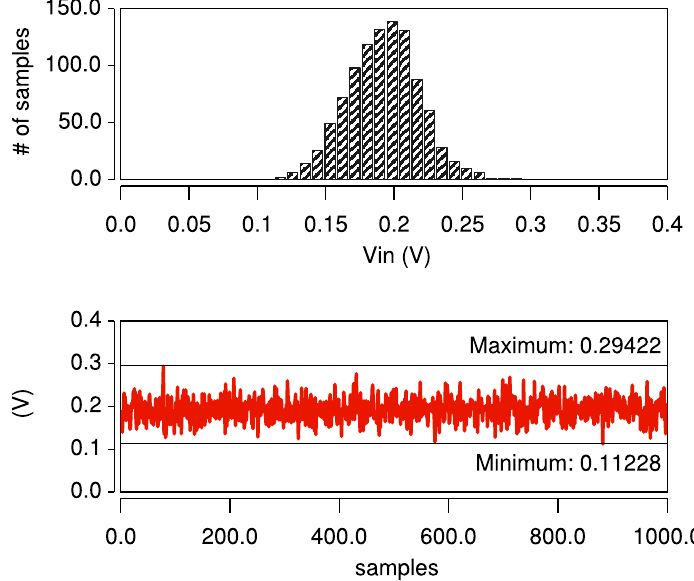
Figure 6. Monte Carlo simulation of the cross-coupled inverters to find the trip voltage. ( top ) The histogram and ( bottom ) the input (output) voltage